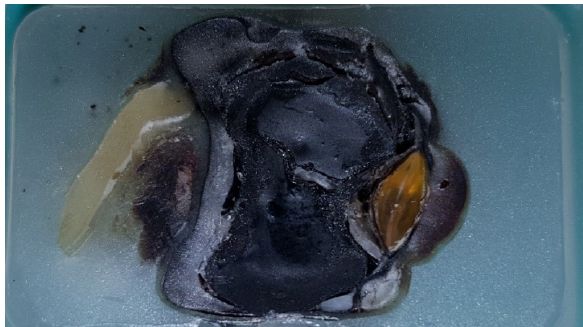
Figure 2: Gross antero-posterior section of the right eye embedded in paraffin block